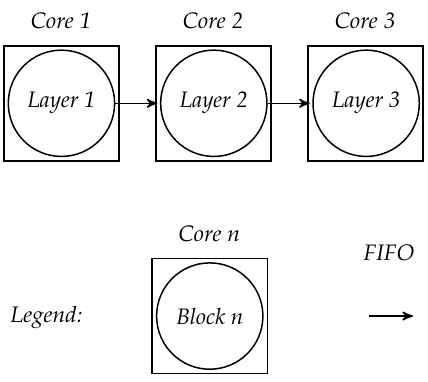
Figure 7. One core for each convolutional layer.